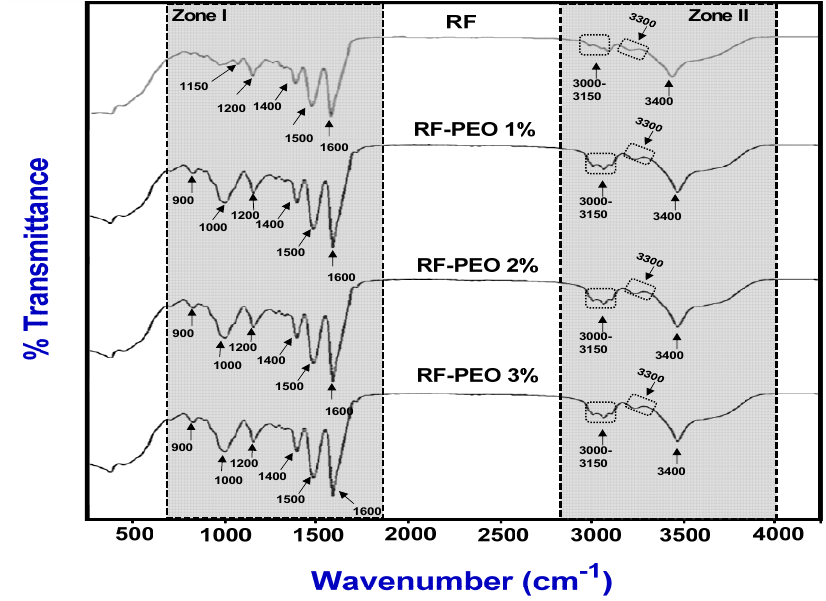
Figure 6. FTIR spectrum of edible films composed of RF-PEO at varying concentrations.